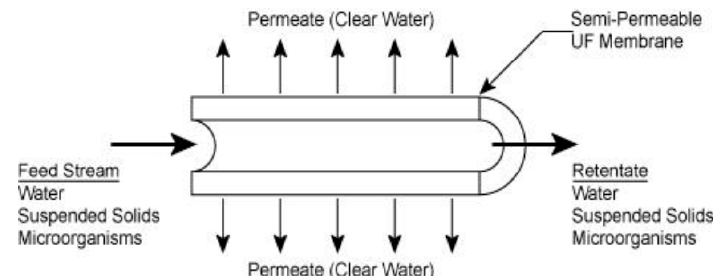
Figure 3. The scheme of ultrafiltration process.